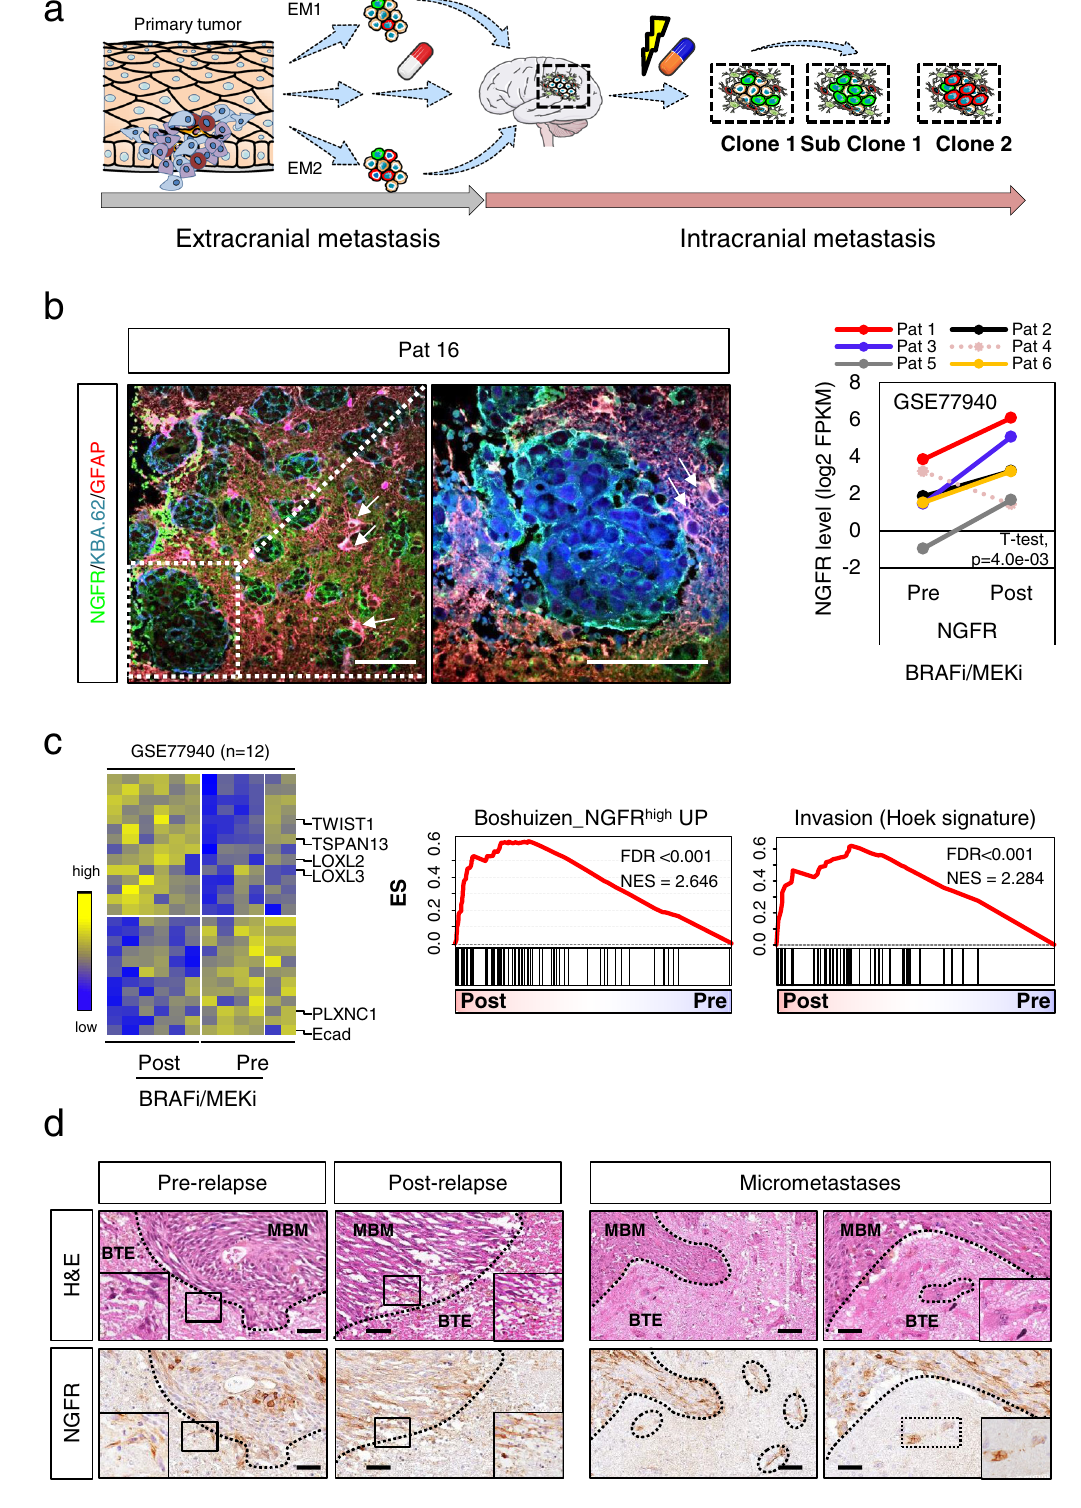
levels of both (Supplementary Fig. 3d) and determined genes that correlated with Ecad or NGFR expression. The comparison of Ecad high vs Ecad low and NGFR high vs NGFR low MBM identi fi ed ~2400 DEGs ( p ≤ 0.05) (Supplementary Data 3) and revealed an inverse association of Ecad and NGFR correlating genes (Supplementary Fig. 3e, left panel). Moreover, we found a correlation of the BRAF/NRAS mutation status of MBM, suggesting increased expression of NGFR ( p =0.014) in